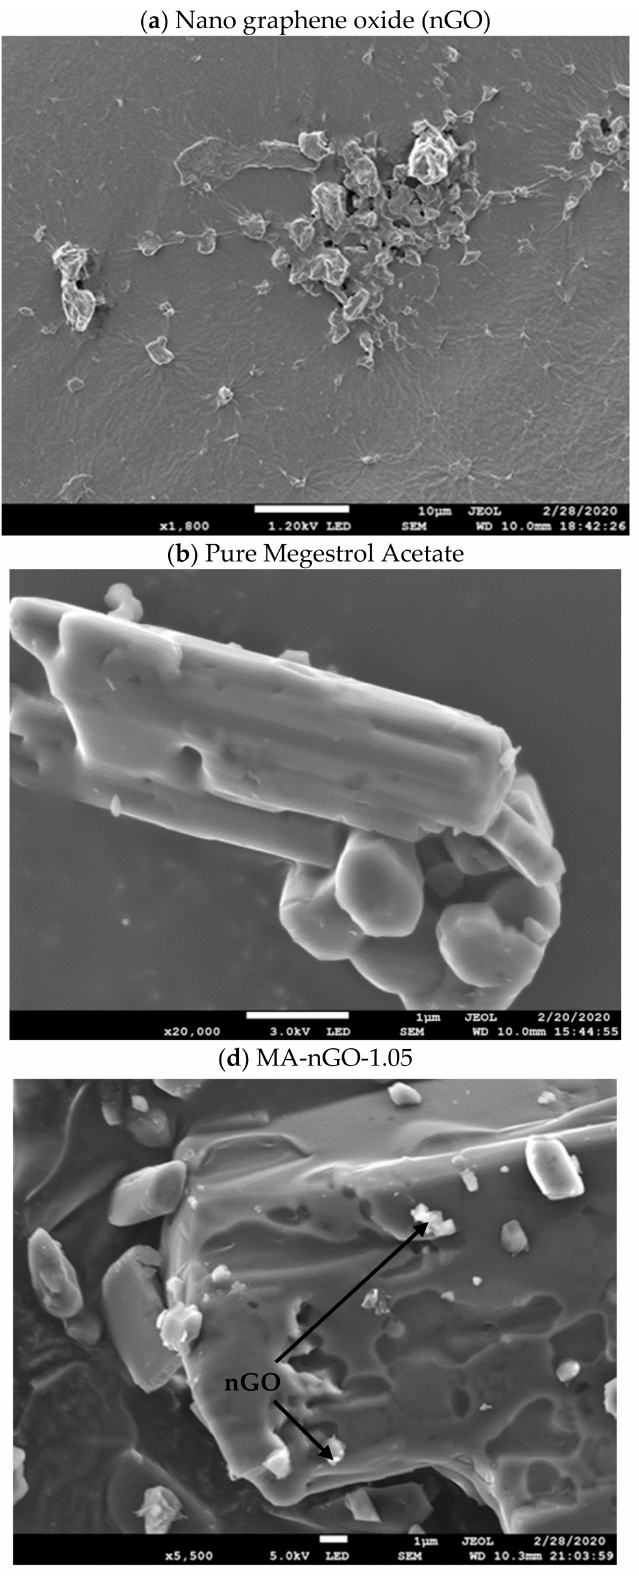
Figure 2. Scanning Electron Microscope (SEM) images of ( a ) nano graphene oxide, ( b ) pure megestrol acetate, ( c ) MA-nGO-1.04, ( d ) MA-nGO-1.05, and ( e )